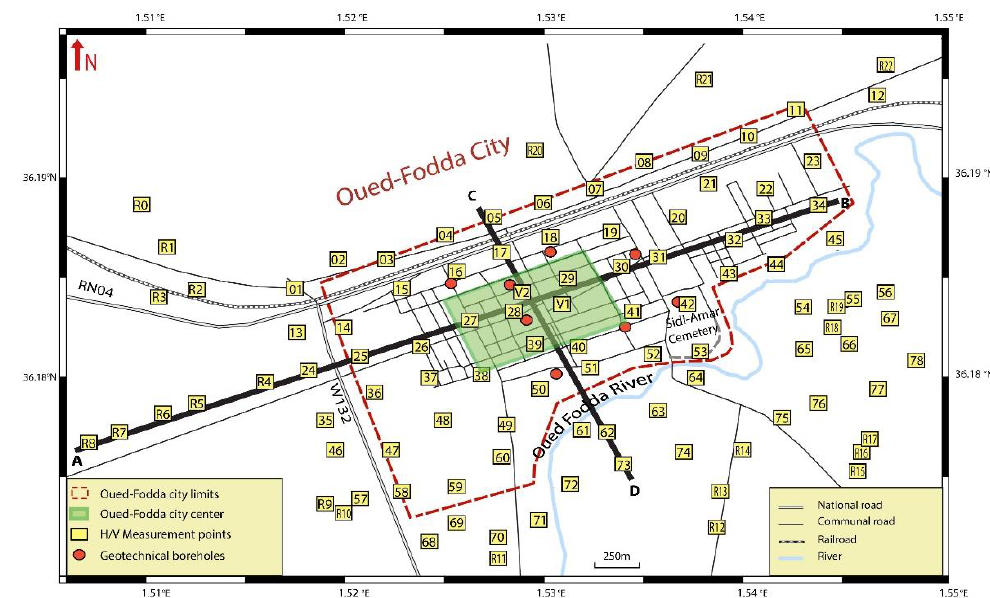
Figure 3. HVSR measurement points (yellow squares) and boreholes (red dots). The two black lines (AB and CD) indicate two cross-sections of Vs profiles.